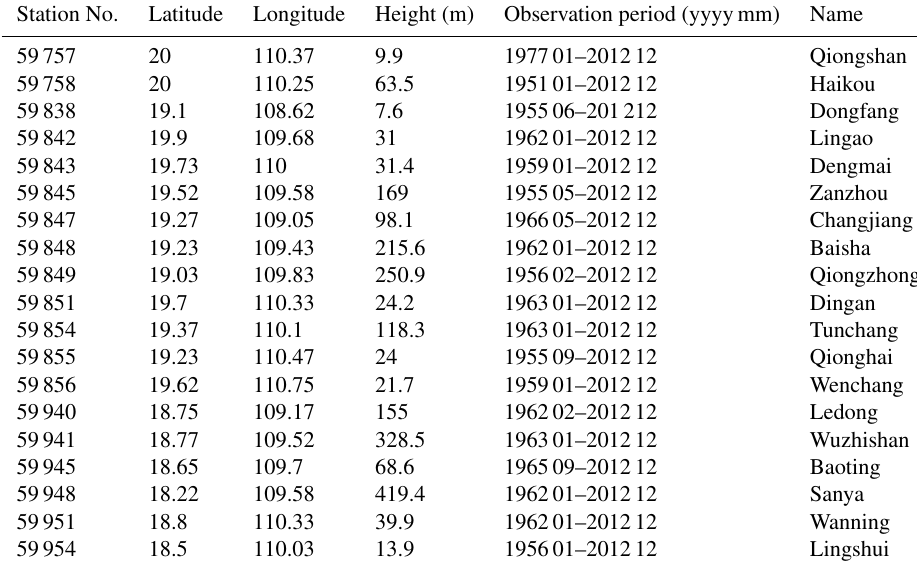
Table 1. Station observation period used over Hainan Island. Station